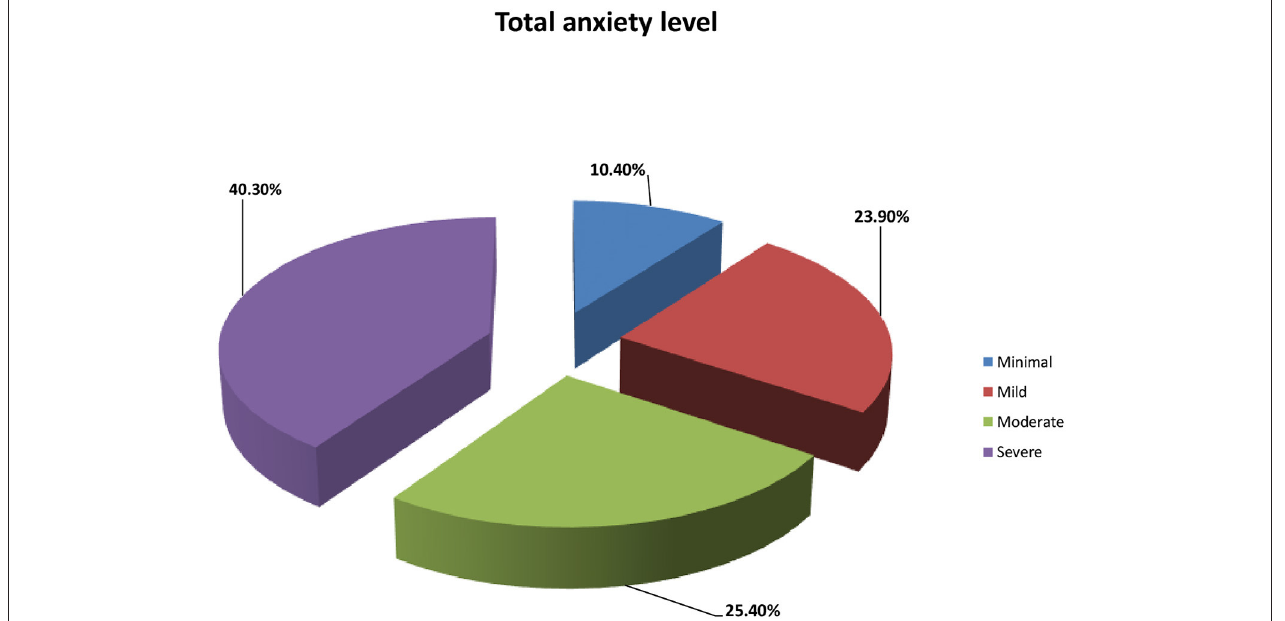
FIGURE 1 | Distribution of the studied critical care nurses according to their total anxiety level ( n = 469).